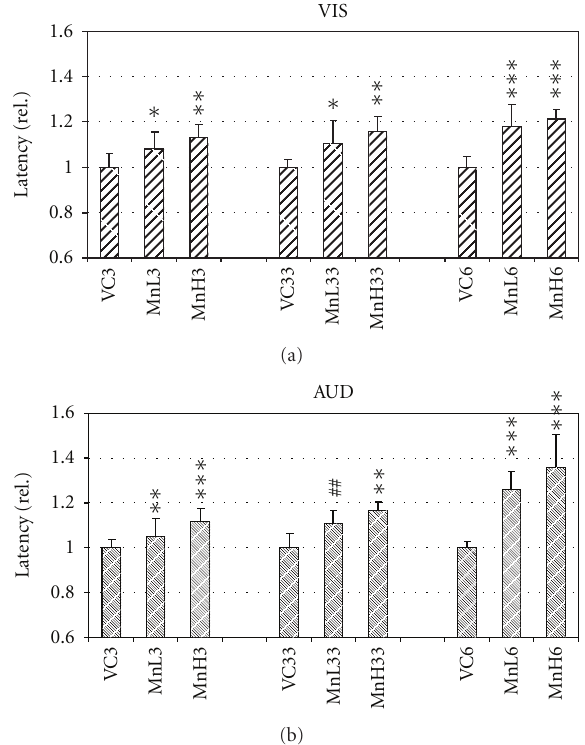
Figure 3: Latency of the visual (a) and auditory (b) evoked potentials in the control and treated rats. Mean + SD, n = 8. The relative data were calculated as given at Figure 2. ∗ , ∗∗ , ∗∗∗ : P < 0 . 05, 0.01, 0.001 treated versus VC; ## : P < 0 . 01 MnL33 versus